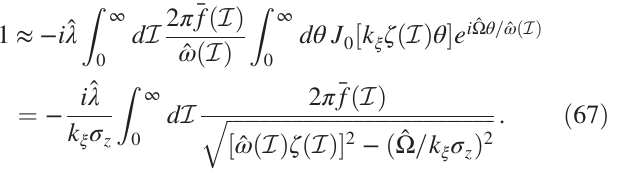
TABLE II. Parameters of the double rf system used in ELEGANT simulations. Parameter Symbol Value Main rf voltage V Main rf frequency f Main rf phase ϕ 1 138.3° Harmonic number h 4 Harmonic voltage V 4 0.88 MV Harmonic phase ϕ 4 347.4°